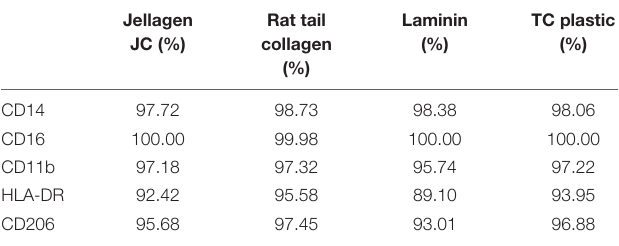
TABLE 1 | Cell surface protein expression. iMGL where cultured on Jellagen R (cid:13) (JFC), rat tail collagen I (RTC), Laminin and TC plastic for 48 h and receptor expression was quantified using flow cytometry.